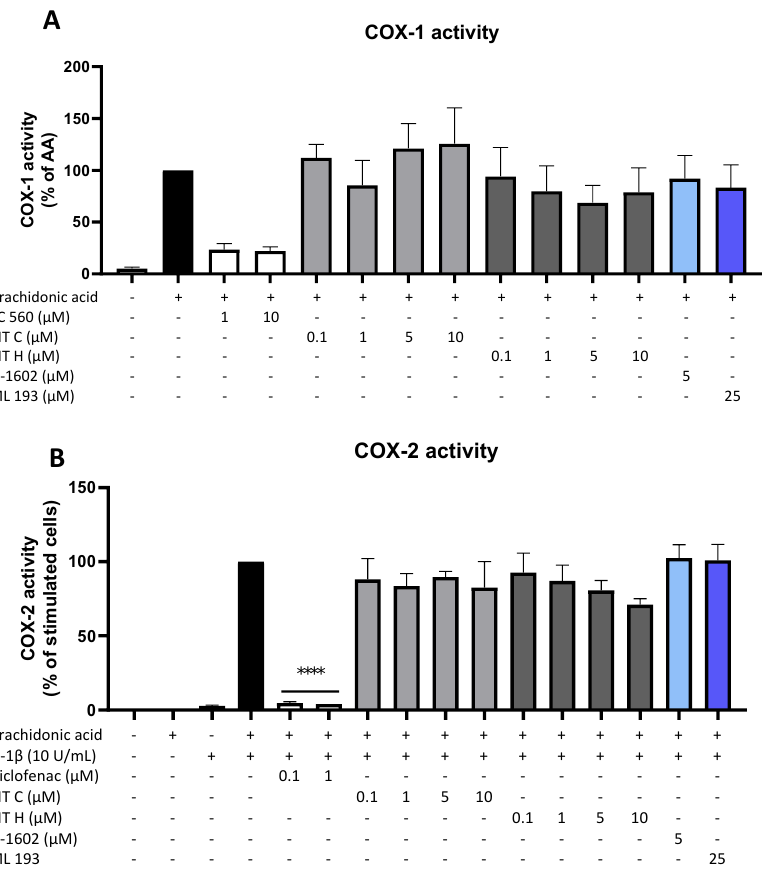
Figure 5. Effects of KIT C (light grey bars), KIT H (dark grey bars), O-1602 (light blue bar), and ML 193 (blue bar) on COX-1 ( A ) and COX-2 enzyme activities ( B ) in SK-N-SH cells. ( A ) COX-1-activity was measured after 15 min of incubation with arachidonic acid (AA). Levels of PGE 2 in the supernatants were quantified by EIA. ( B ) After 24 h of IL-1 β pre-stimulation, 15 µ M of arachidonic acid (AA) was added and PGE 2 -release was measured by EIA. Values are presented as the mean ± SEM of at least three independent experiments. Statistical analysis was carried out by using one-way ANOVA with Dunnett’s post hoc tests with **** p < 0.0001 compared to AA (A) or IL-1 β with AA ( B ).